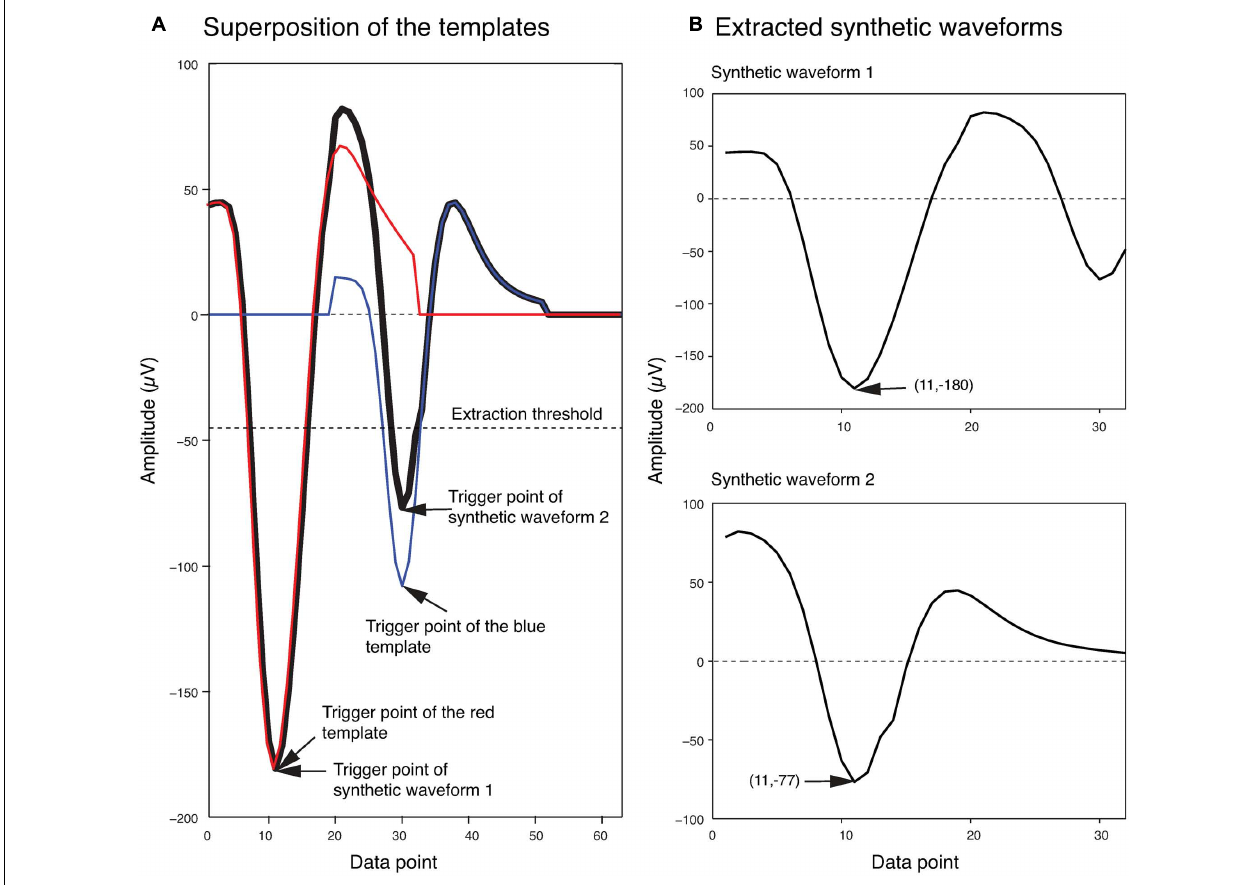
FIGURE 3 | Extraction of synthetic waveforms. (A) Superposition (thick black line) of two templates (red and blue lines) with their trigger points separated by 19 data points. (B) Extracted synthetic waveforms. The data point number and amplitude of the trigger points are shown in